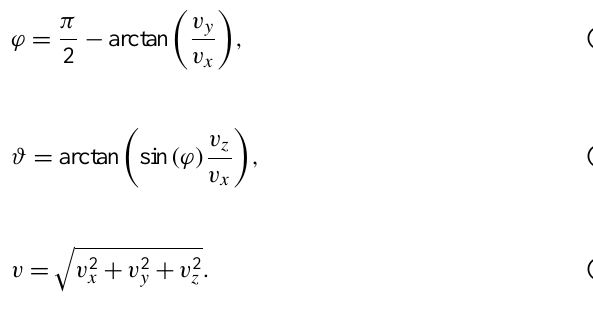
Fig. 4. Trajectory of the meteor in zenith distance angle ( 2 ) with colour coded altitude, right ascension (RA), declination (DEC) ve- locity and begin/end altitude parameters are located in the left cor-